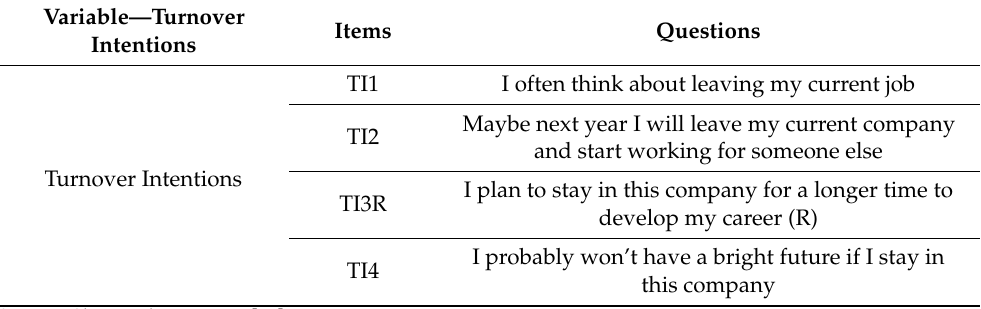
Table 3. Questions about the dependent variable—Turnover Intentions (4th